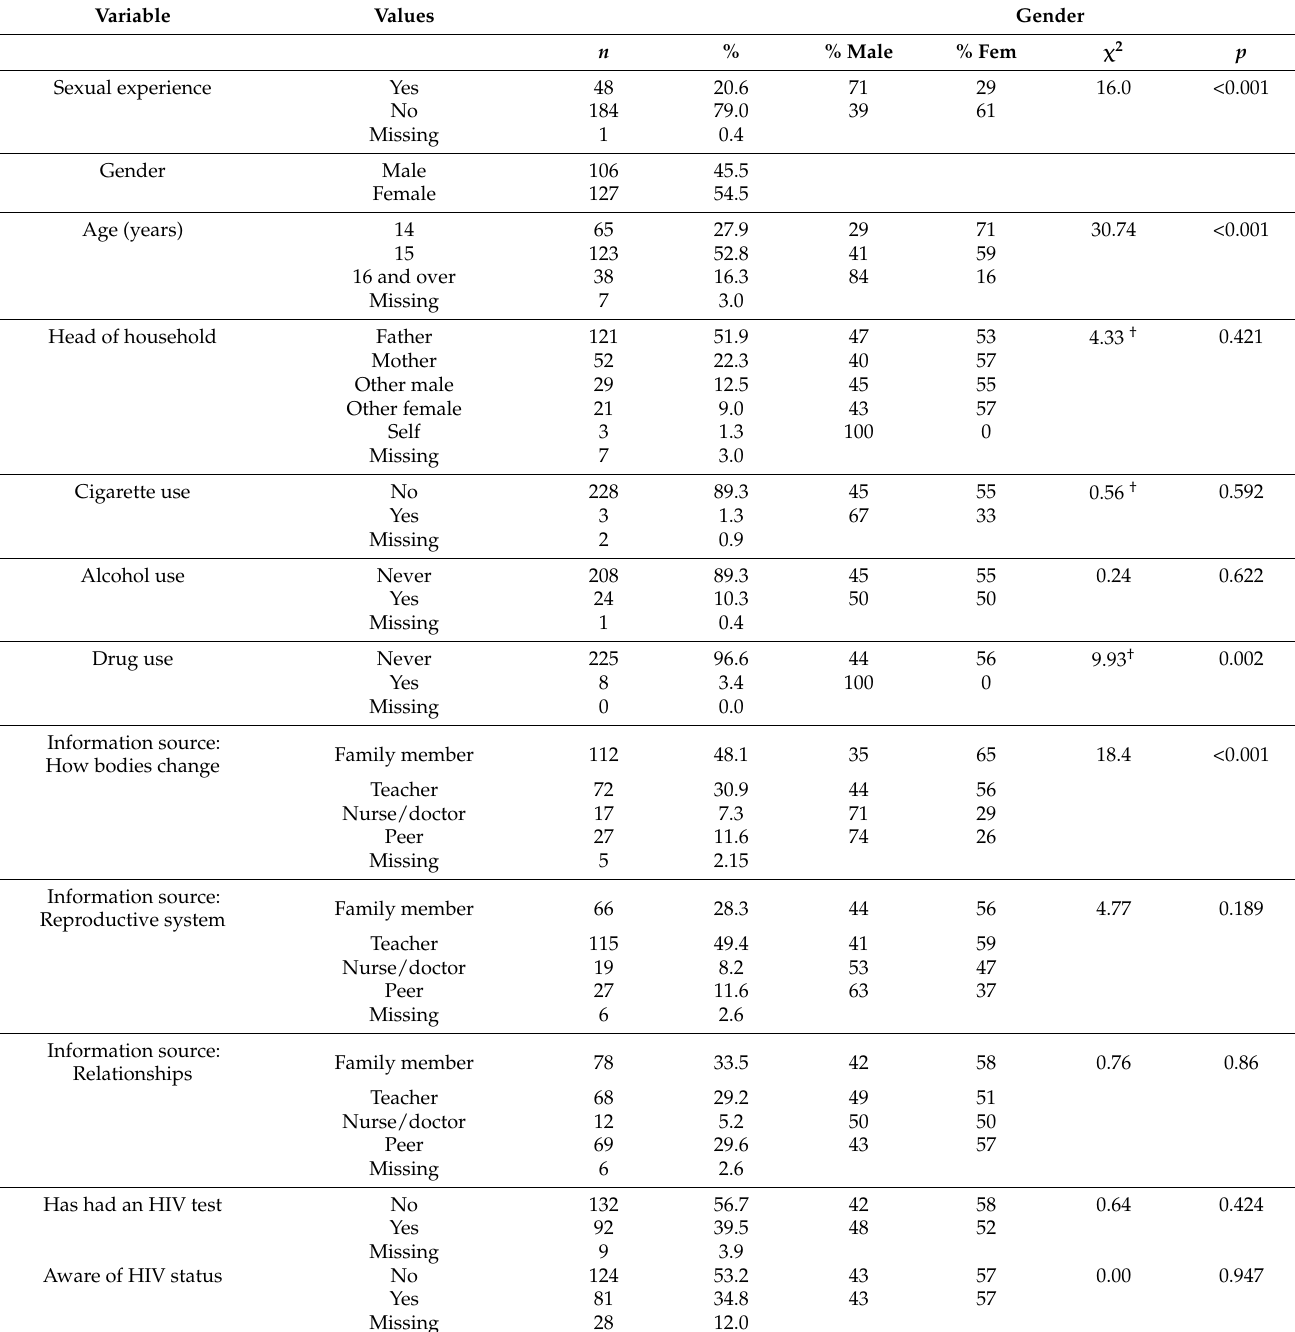
Table 2. Distribution of respondents by sociodemographic attributes and behaviors according to gender of respondent (N = 233).